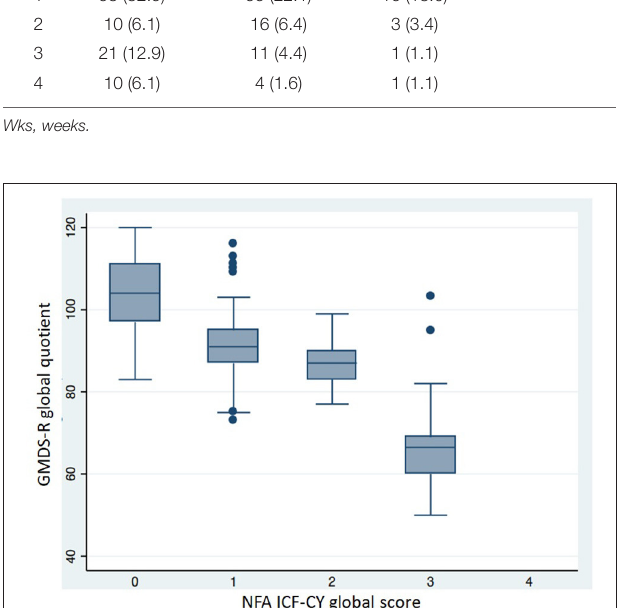
FIGURE 5 | Comparison of GMDS-R global quotient in patients with different NFA ICF-CY score. Patients with tetraparesis and blindness were excluded. Kruskal-Wallis test: p < 0.001.